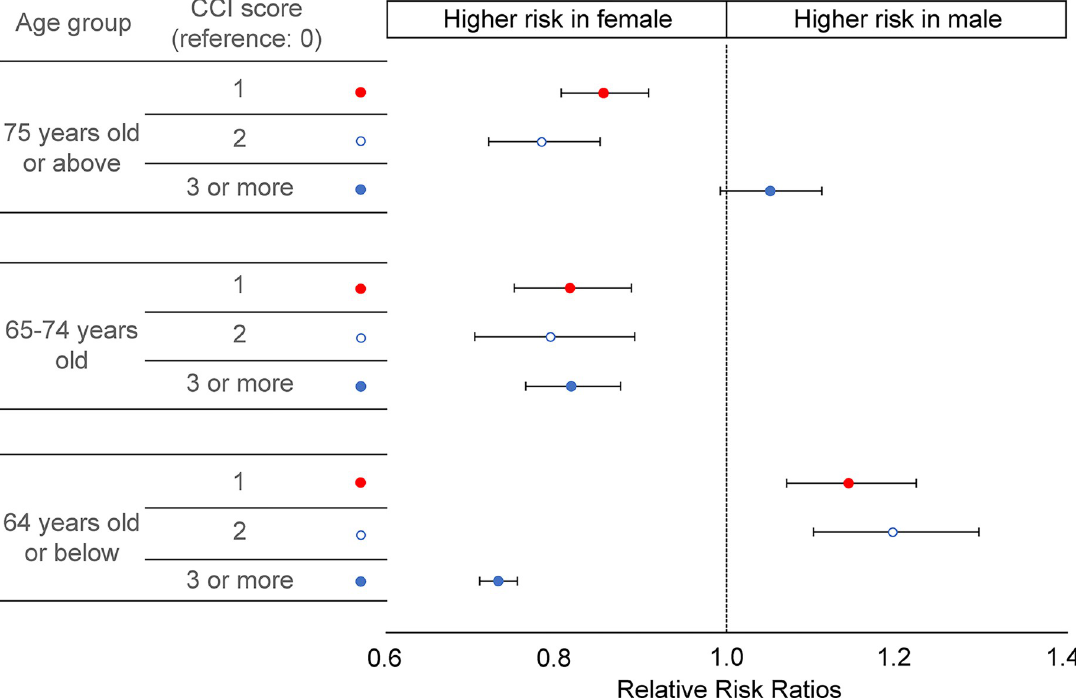
Fig 1. Associations between the Charlson comorbidity index and gender by age group. Multinomial logistic regression model (reference: Gender = female, CCI = 0; adjusted for region, nationality, household income, lesions of tuberculosis, type of tuberculosis, notified health institution, and acid-fast bacilli smear and culture results). CCI = Charlson comorbidity index.